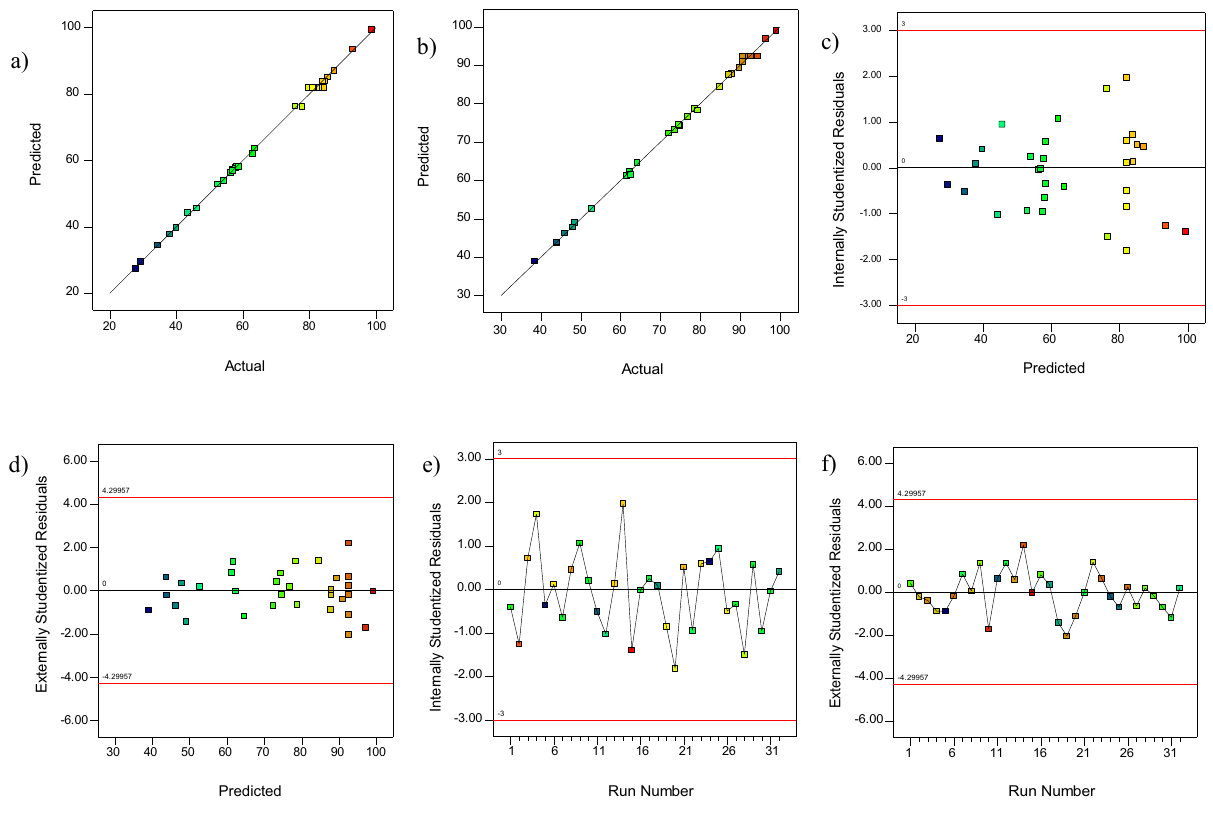
Figure 4. Plot of predicted value versus actual value (a) MG and (b) AO, plots of residuals for removal of (c,e) MG and (d,f)